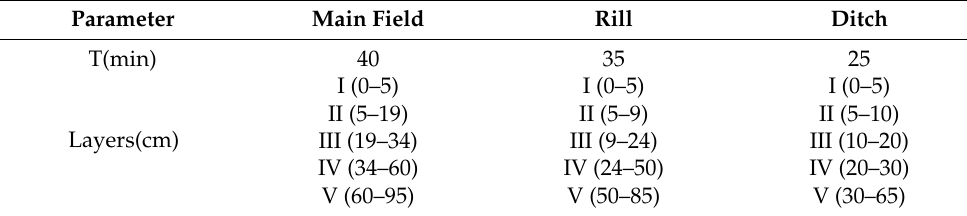
Table 7. Model parameters of three kinds of topographic subunits in 20160406 rainfall event.